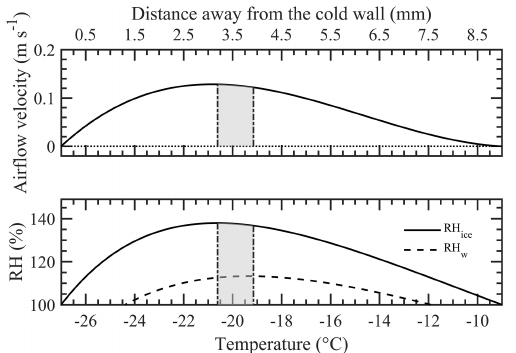
Figure 3. Steady-state airflow velocity and relative humidity (RH) conditions calculated using the mathematical model developed by Rogers (1988) within the conditioning section of the ice chamber. The chamber warm wall (left) and the cold wall (right) are at − 9 and − 27 ◦ C, respectively. The shaded area between the two verti- cal dash-dotted lines shows the boundaries of aerosol lamina un- der at these above temperatures and flow conditions (sheath flow: 5Lmin − 1 ; sample flow: 1Lmin − 1 ). The profiles are asymmet- ric because of the thermophoretic drift of the flow, caused by the thermal gradient between the walls, towards the colder wall. The conditioning section is always supersaturated with respect to ice (RH ice > 100%), and except the near-wall positions, the section is also supersaturated with respect to water (RH w >